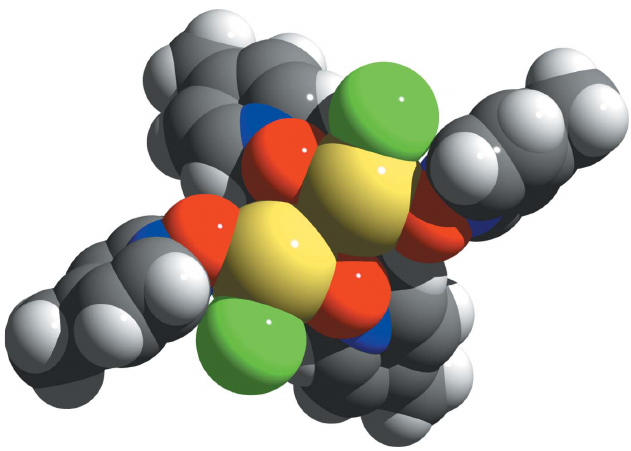
Figure 5 Space-filling model of the dimeric aggregates found in the crystal structure of 2 looking down into the voids on the backside of the tin atoms; color code used: Cl = green, O = red, N = blue, C = black, H = gray, Sn =